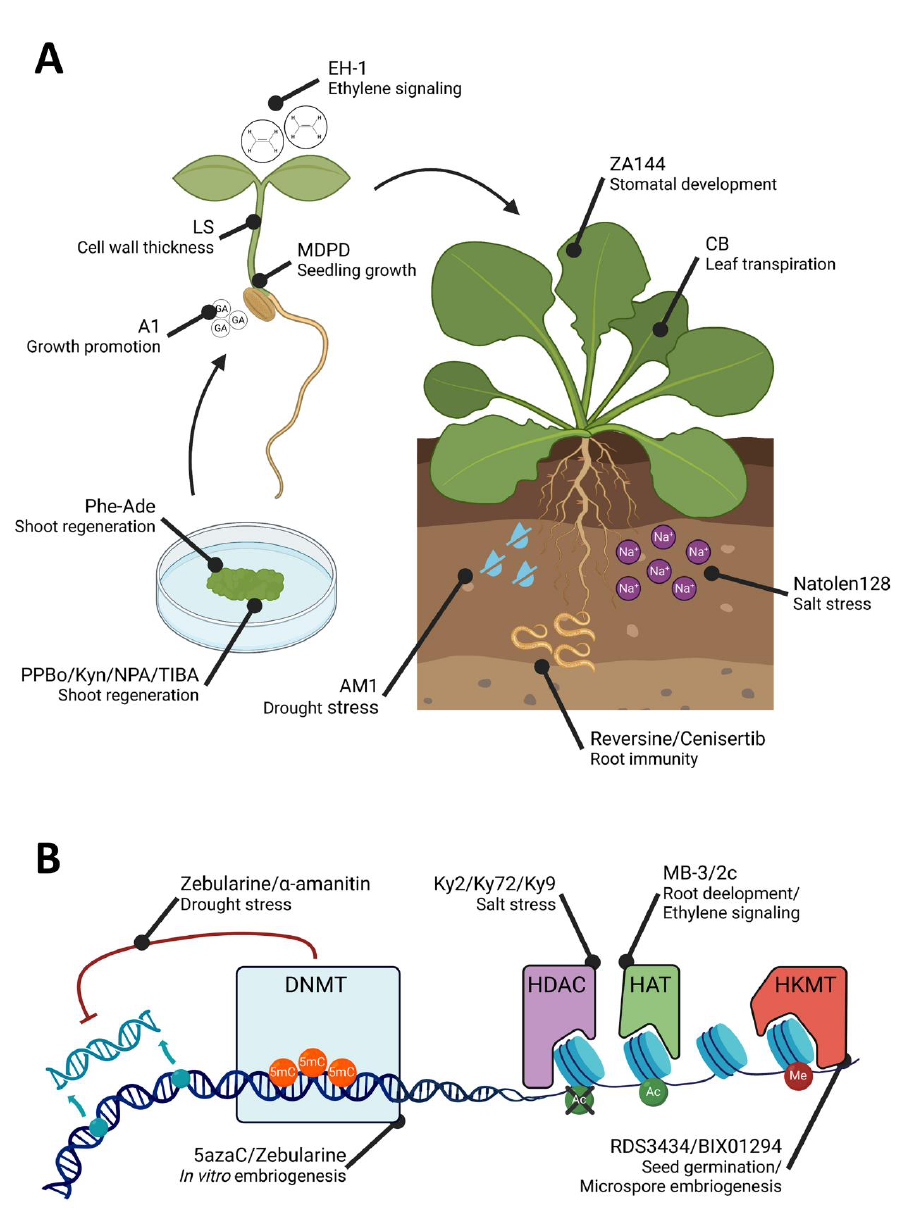
Figure 2. Small molecules involved in plant morphogenesis and stress response ( A ) and epigenetic processes ( B ). The figure shows different molecules described in the review and the processes in which they are involved. ( A ) Seedling growth. ( B ) DNA methylation. Created with BioRender.com (accessed on 6 April 2023).